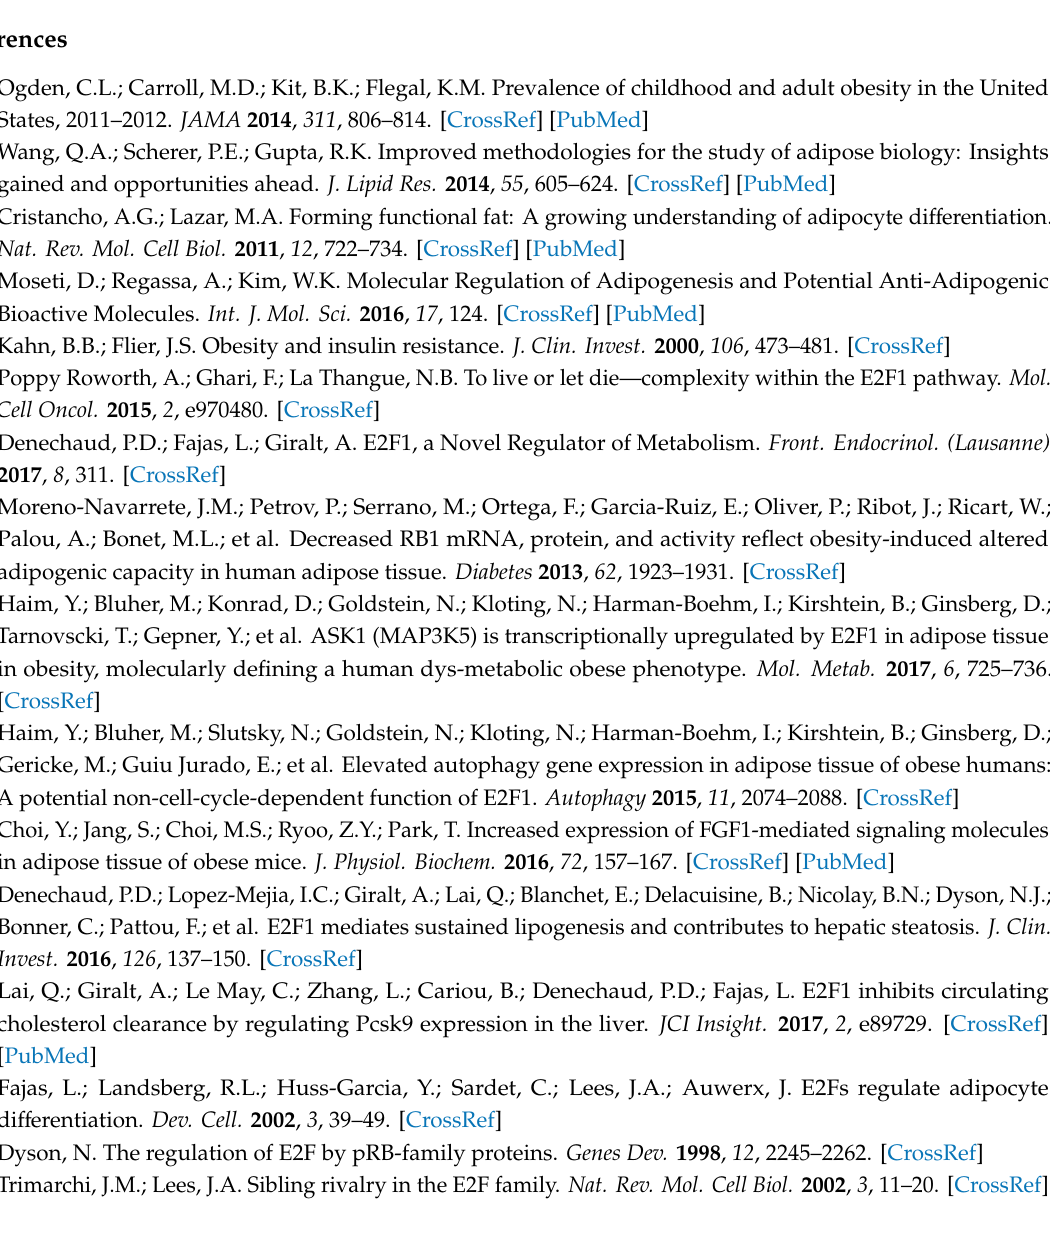
Table S1: Primers for RT-PCR. Figure S1: mRNA expressions of adipogenic regulators were enhanced, while Wnt / β -catenin targets were reduced during the di ff erentiation process. Figure S2: Gene expressions of ICAT in 3T3-L1, Hela and HepG2